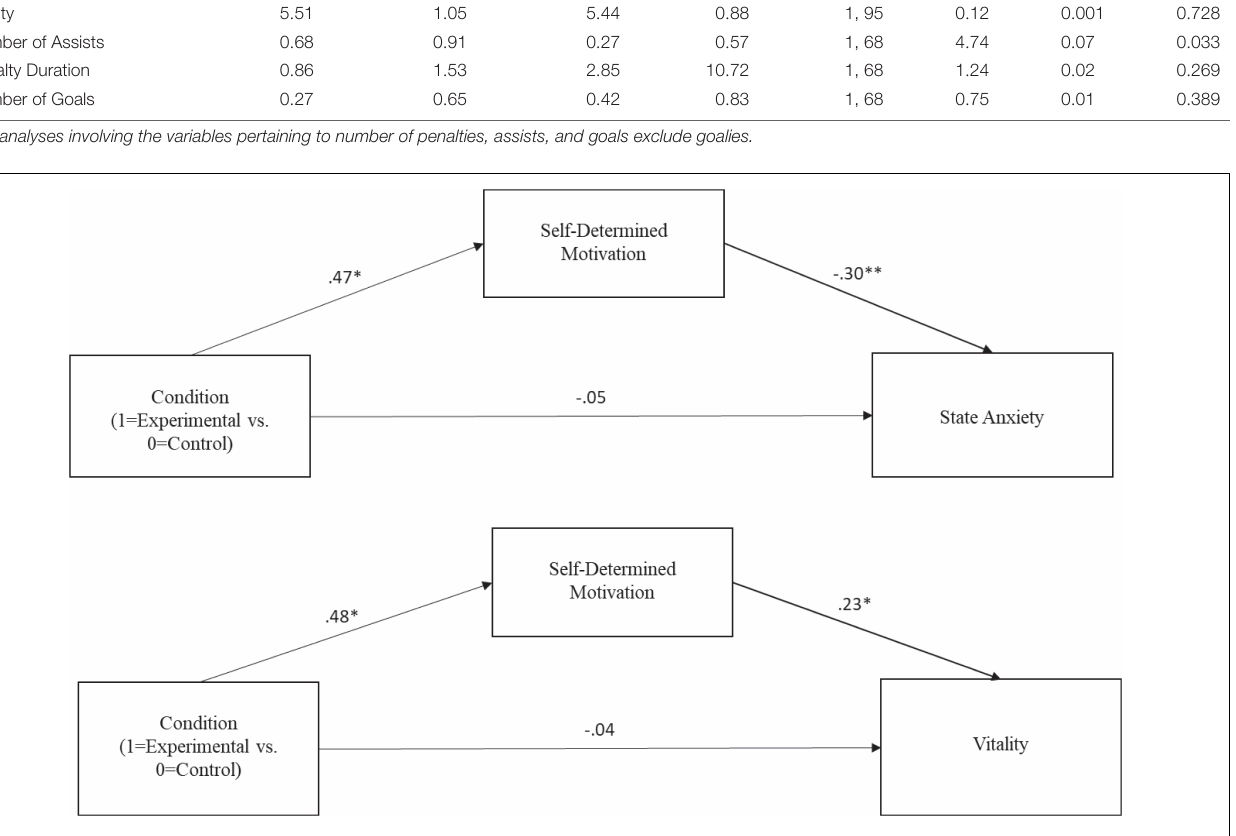
TABLE 2 | Comparison of the experimental and control conditions on the psychological variables and the on-ice behavioral measures. Experimental condition Control condition M SD M SD dfs F η 2 p p 6 . 17